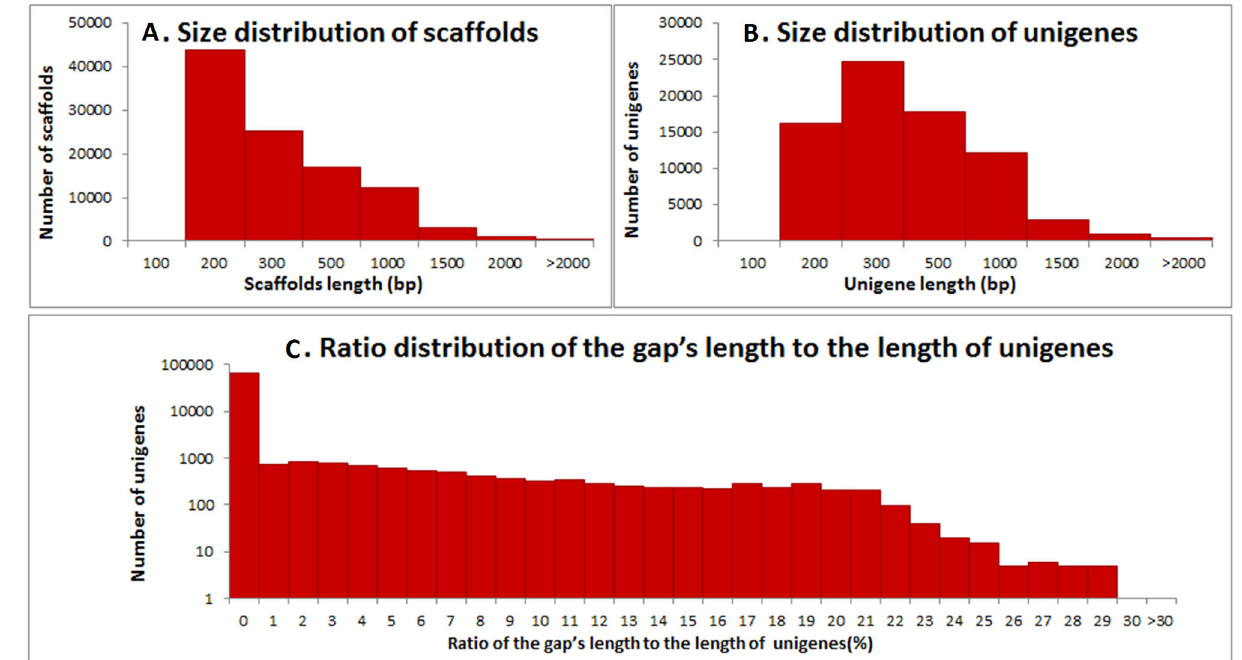
Figure 1. Overview of the C. sinensis floral transcriptome